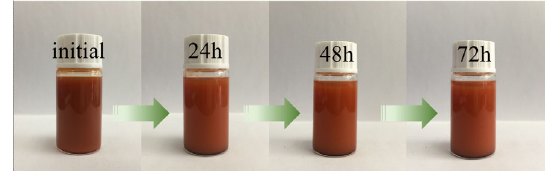
Fig. 8 Photographs of the ceramic ink after 24, 48, and 72